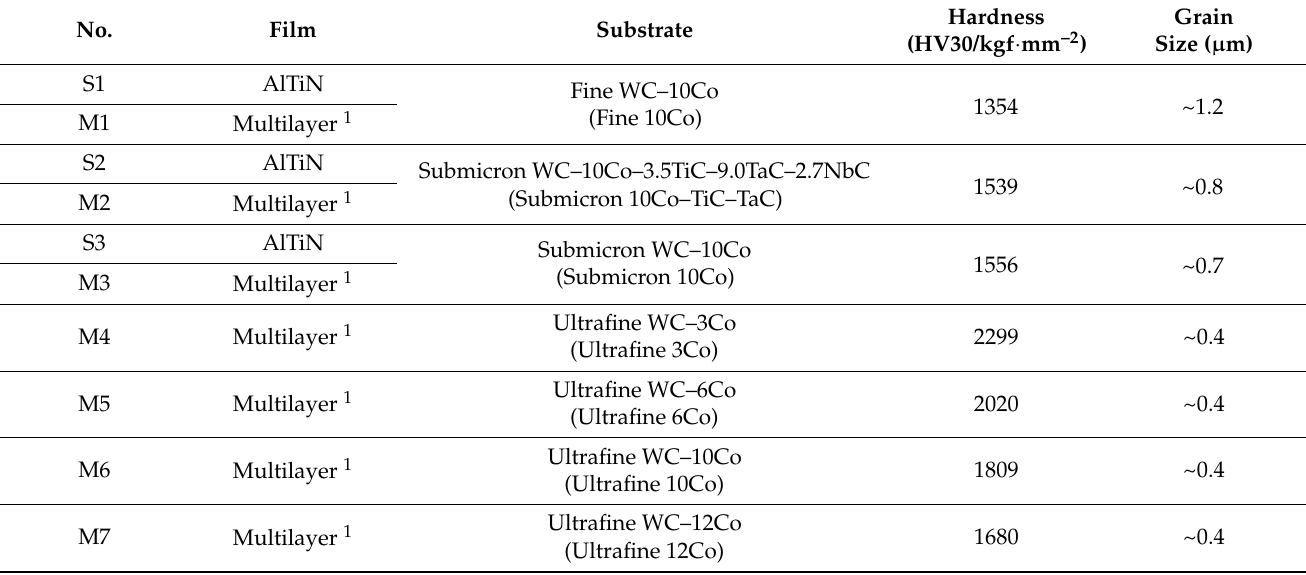
Table 1. Properties of WC–Co cemented carbide substrates and the types of deposited films.